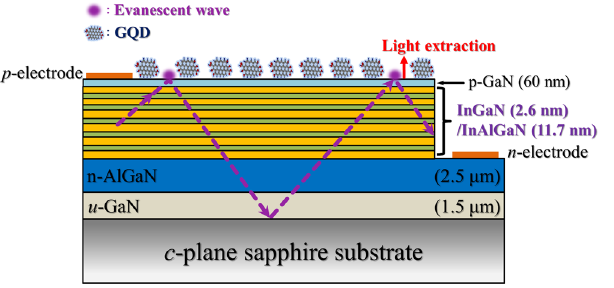
Figure 1. Schematic cross section of the InGaN/InAlGaN UV LEDs. The direction of light extraction was displayed by an